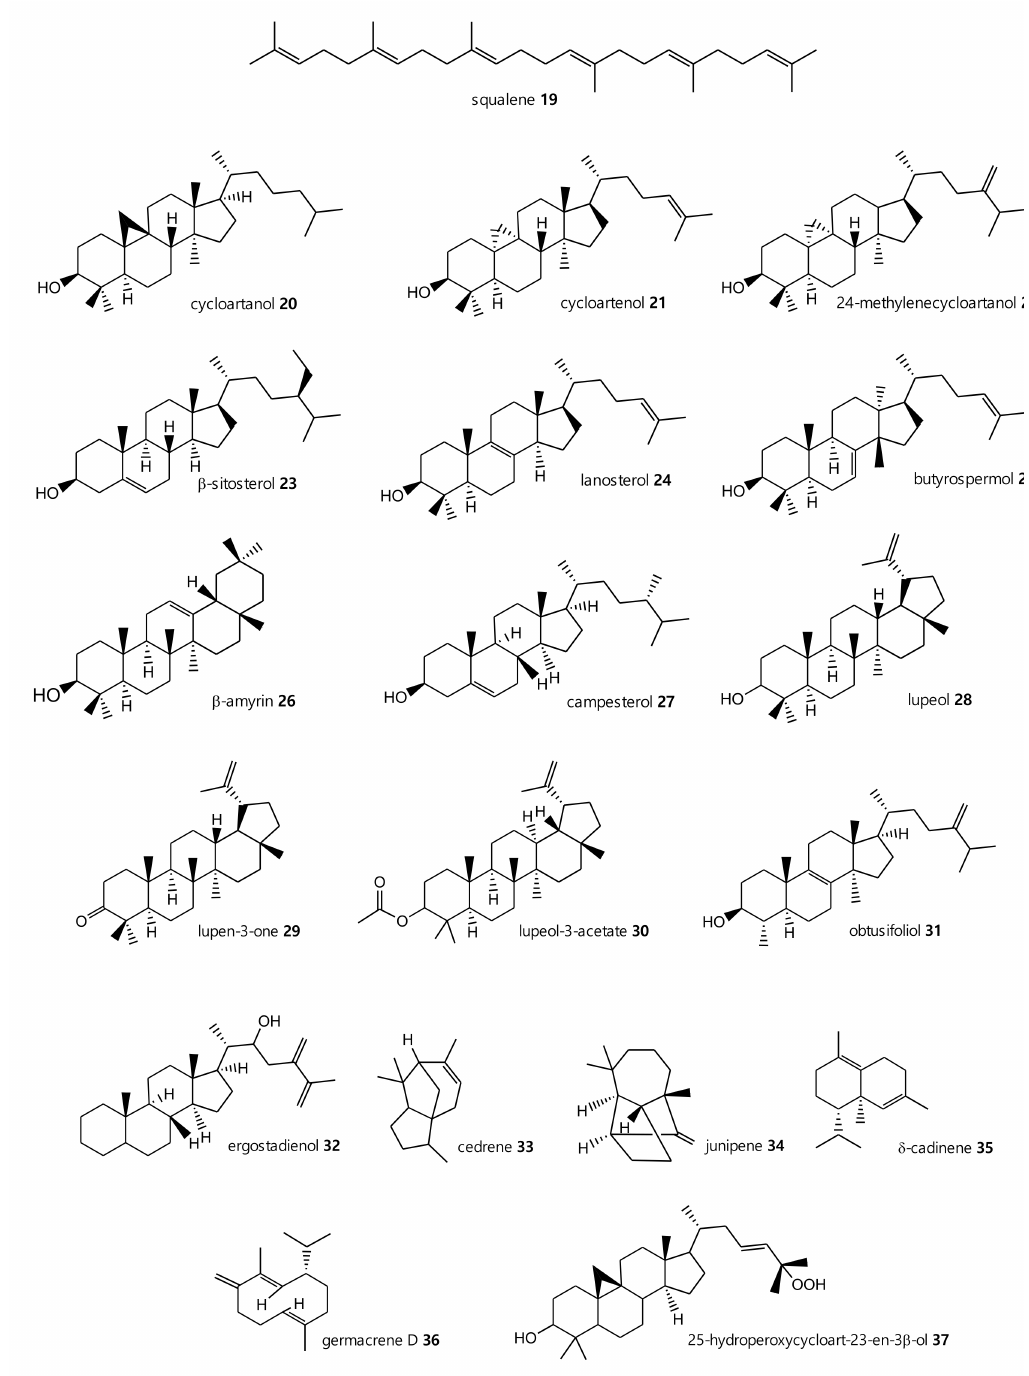
Figure 2. Triterpenes, sterols and sesquiterpenes identified from E. characias latex (compounds 19 , 20 , 22 , 24 , 25 , 28 , 31 – 36 ) [18], seeds (compounds 20 , 22 – 24 , 26 , 27 ) [24] and aerial parts (compounds 19 – 26 , 28 – 30 , 35 – 37 ) [25,27]. Cerebrosides represent a member of the sphingolipid class of lipids, which are also known to be distributed in Euphorbiaceae latex. Nine cerebrosides were isolated and purified from the latex of E. characias (com- pounds 47 – 55 ) (Table 3). Structurally, these cerebrosides are composed of a 1- O - β - D - glucopyranoside linked to a polyhydroxy sphingosine and a 2-hydroxy saturated or unsat- urated fatty